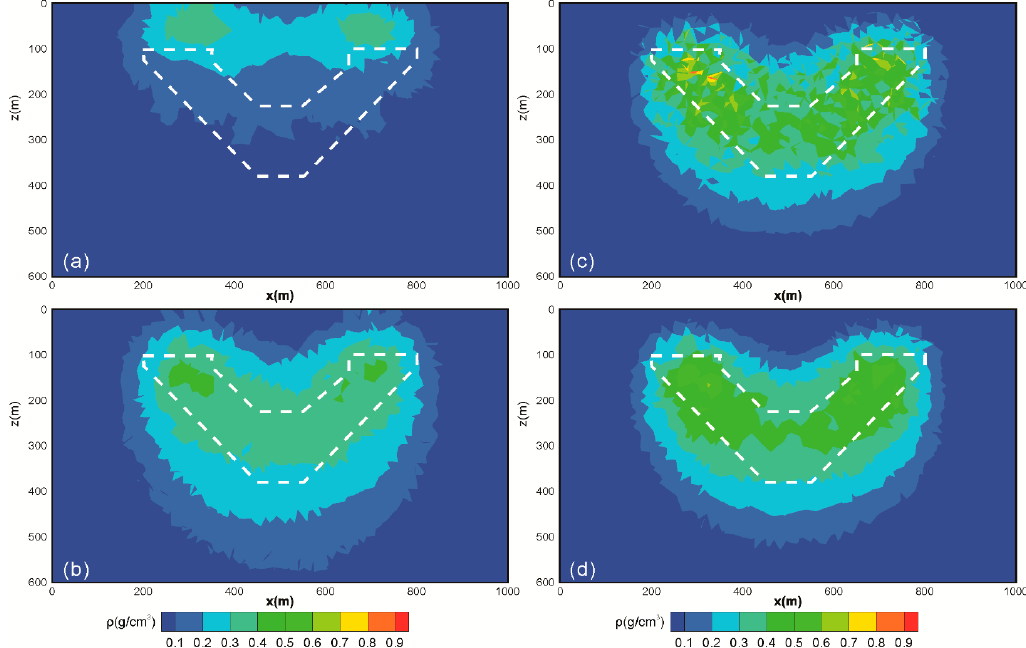
Figure 5. Smooth inversion results. ( a , b ) are conventional strategy with λ = 1 × 10 − 2 and λ = 5 × 10 − 2 ; ( c , d ) are gradient-based strategy with λ = 1 × 10 1 and λ = 5 × 10 1 .